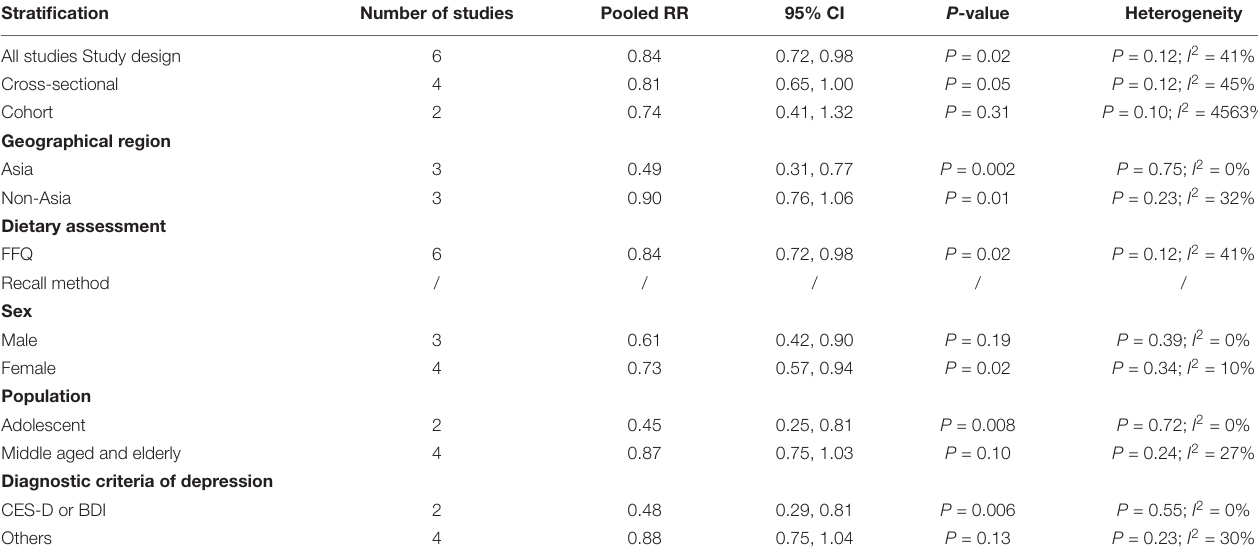
FIGURE 4 | Forest plot of meta-analysis: overall multi-variable adjusted RR of depression for the highest versus lowest category of dietary vitamin E intake. TABLE 4 | Subgroup analysis of depression for the highest versus lowest dietary vitamin E intake